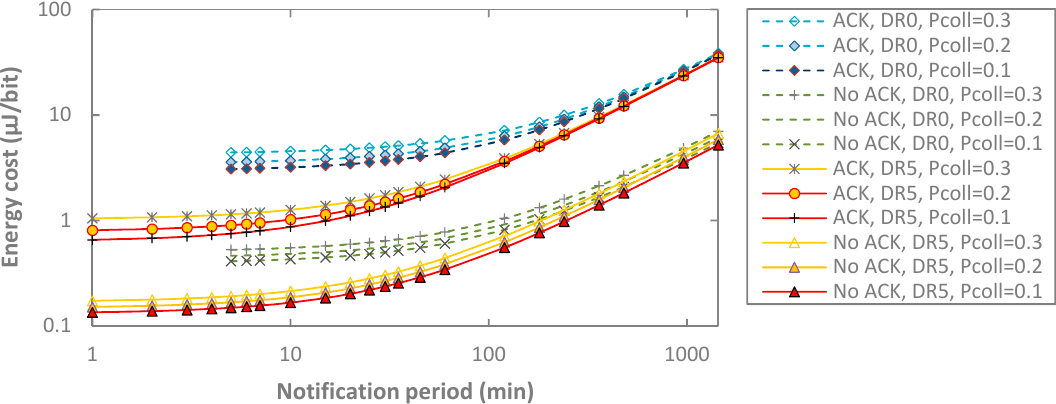
Figure 21. Impact of p coll on the energy cost of data delivery, as a function of T Notif , for both unacknowledged and acknowledged transmission, for BER = 0, and for DR0 and DR5.